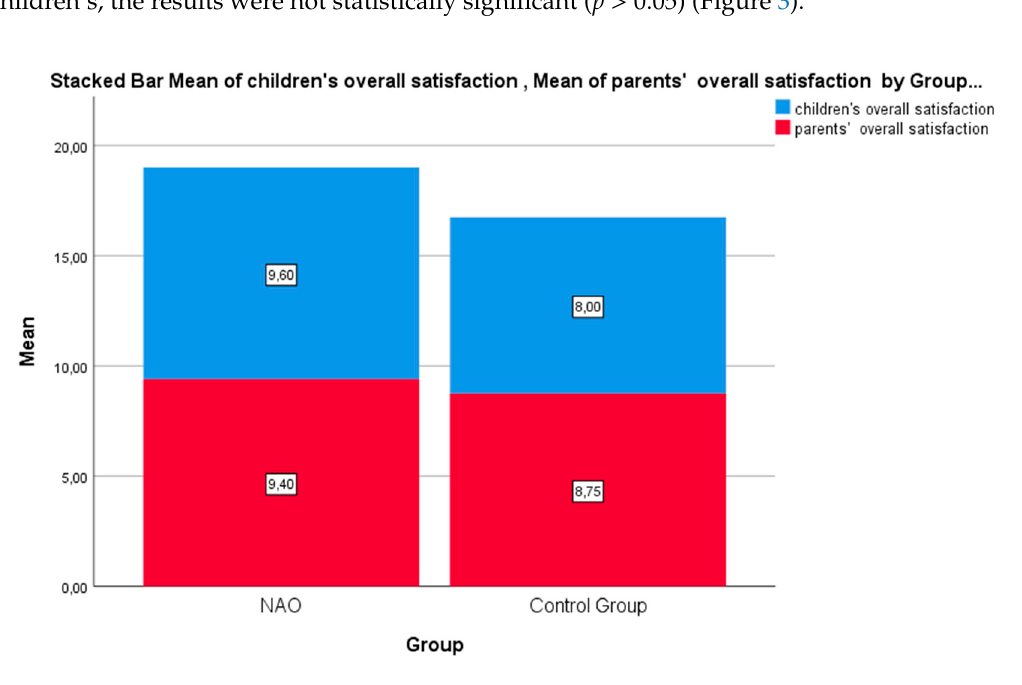
Figure 3. Children’s and parents’ satisfaction by group.